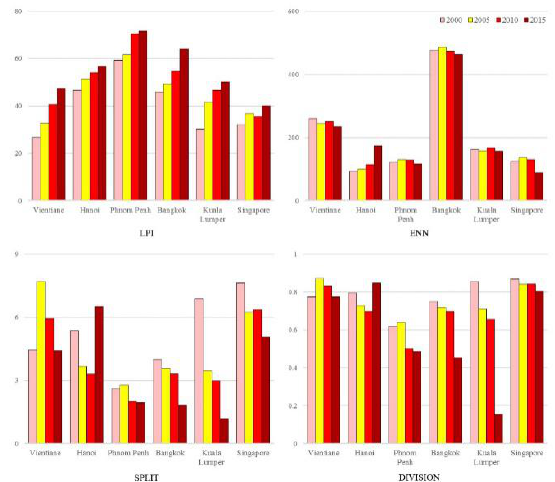
Figure 7. Landscape pattern